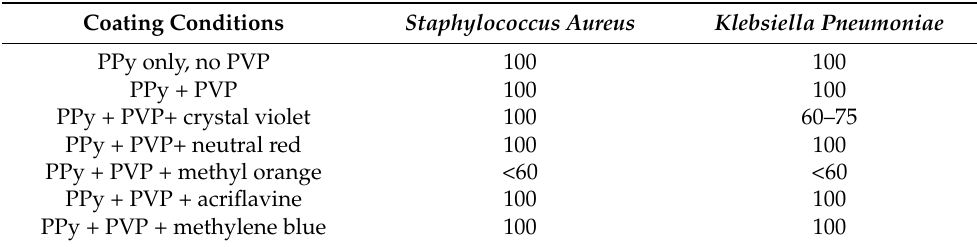
Table 2. Zone of bacterial resistance without any bacterial growth (%) on leather coated with polypyrrole in the presence of poly( N -vinylpyrrolidone) and organic dyes. Coating Conditions Staphylococcus Aureus Klebsiella Pneumoniae PPy only, no PVP 100